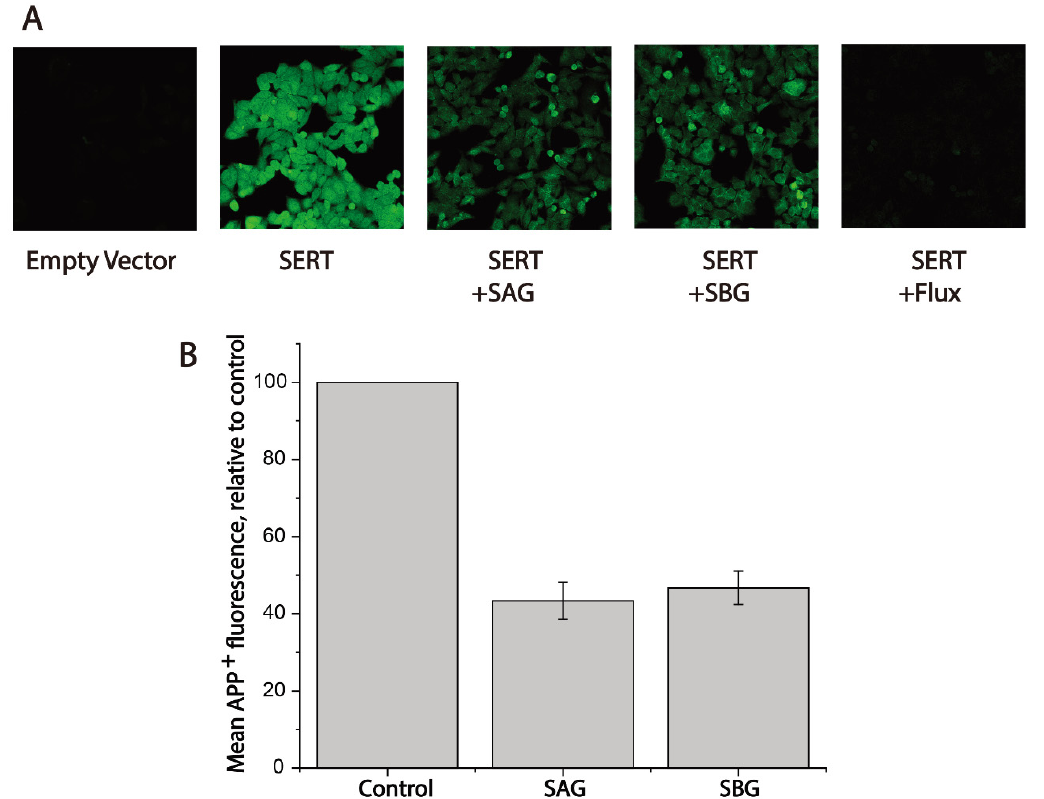
Figure 4. Fluorescence image analysis for inhibition of APP + uptake by SAG and SBG. Cells trans- fected with hSERT or empty vector were wet-mounted on polylysine-coated glass slides and incubated with APP + in the absence or presence of SAG (5 µ M), SBG (8 µ M), or fluoxetine (10 µ M) for 5 min. After 3 × washing, accumulated APP + fluorescence images were acquired and counted as described under Section 4. ( A ) Confocal fluorescence images parallelly acquired from one experiment. Experiment was repeated twice more with similar results. ( B ) Quantitative analysis for inhibition of APP + uptake by SAG and SBG. In each experiment, at least ten cells were randomly selected for quantitative analysis (n ≥ 10). Accumulated APP + fluorescence within cells counted using Zen Blue software and normalized to cell areas. Nonspecific uptake measured in the presence of 10 μ M fluox- etine and subtracted when APP + uptake was calculated. Graph is a combination of three experi- ments. All error bars represent the SEM.